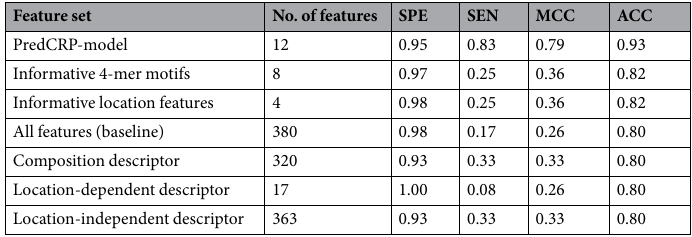
Table 2. Prediction performance comparisons between PredCRP-model and the SVM-based method with various feature sets on the CRPS-TST dataset.